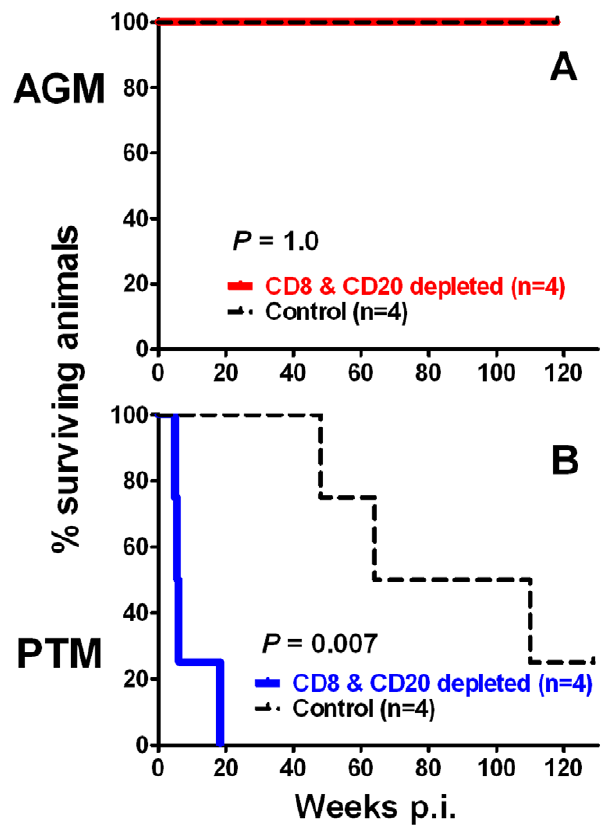
Figure 5. Reduced survival of SIV agmVer90 -infected CD8 + and CD20 + lymphocyte-depleted PTM in contrast to disease-free survival of AGM. Kaplan-Meier survival curves for CD8 + and CD20 + lymphocyte-depleted and historic control vervet AGM ( A ) and PTM ( B ) are shown. Differences in survival were determined by log rank test. memory CD4 + T cells at peak viremia, as indicated by a higher ratio of naı¨ve to memory CD4 + T cells than before infection ( Fig. 8A, B ) in all but one SIV-infected AGM. The non-infected lymphocyte-depleted AGM experienced a similar increase in the ratio of naı¨ve to memory CD4 + T cells as SIV-infected AGM ( Fig. 8A ). In AGM, memory CD4 + T cells express higher levels of CD8 a than naive CD4 + T cells (data not shown) and therefore may be preferentially depleted by the anti-CD8 mAb. After the transient loss of memory CD4 + T cells, the naı¨ve to memory CD4 + T cell ratio recovered to levels comparable to pre-infection ratios, with the exception of A7. A7 recovered from the initial loss of memory CD4 + T cells to a higher, but nevertheless stable ratio of naı¨ve to memory CD4 + T cells. As described above, one of the AGM (A346) suffered an almost complete loss all of its peripheral blood CD4 + T cells ( Fig. 7A ). The loss of CD4 + T cells also included a precipitous decline of naive CD4 + T cells as indicated by the decline in the naive to memory CD4 + T cell ratio indicated ( Fig. 8A ).